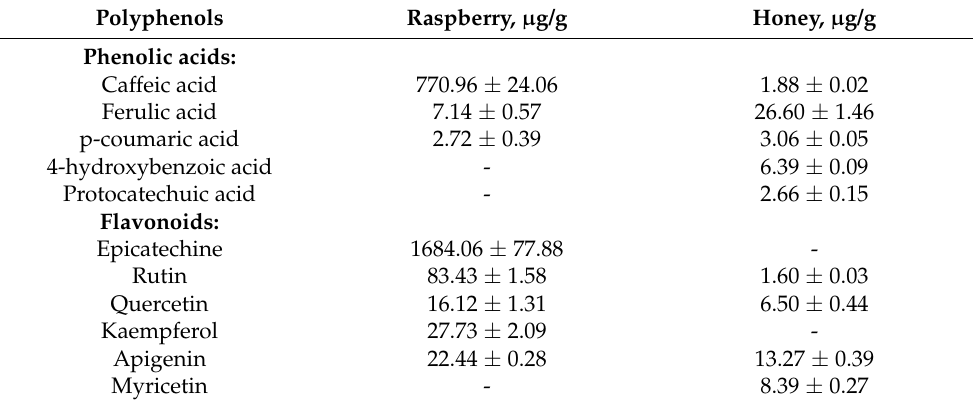
Table 2. Polyphenols (phenolic acids and flavonoids) from raspberry and honey by HPLC analysis.